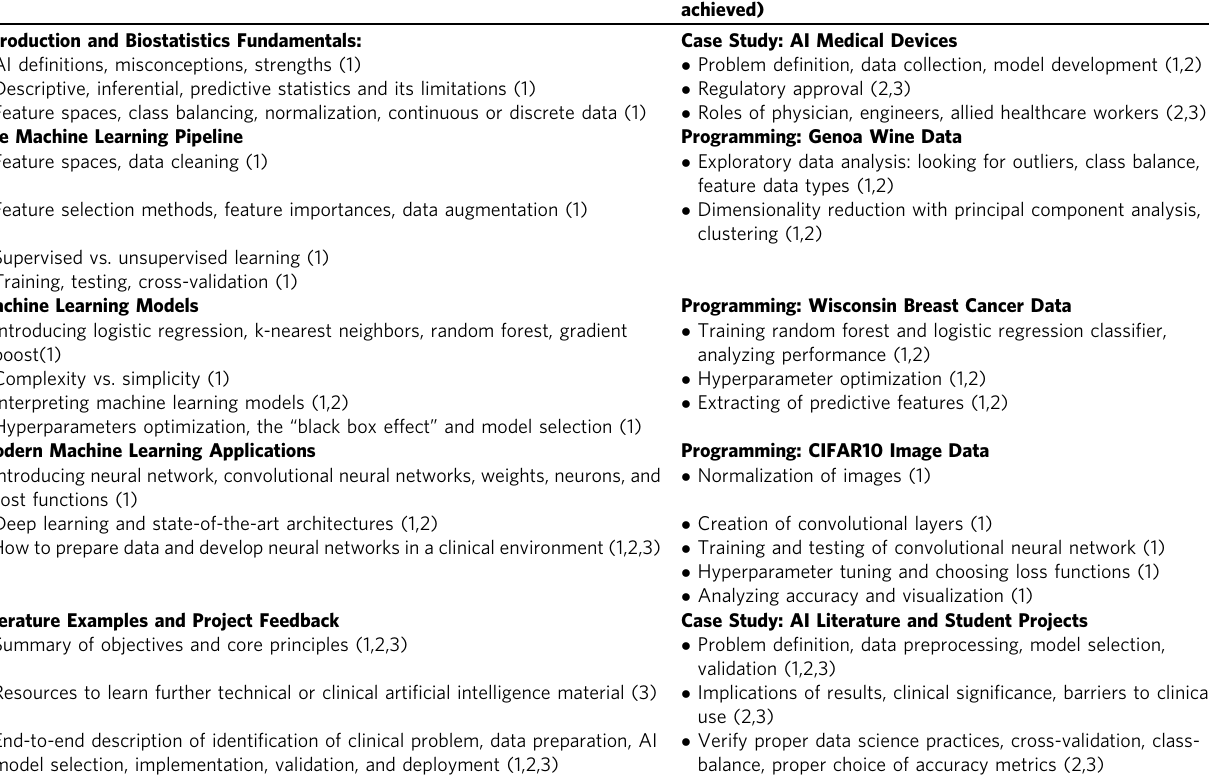
Literature Examples and Project